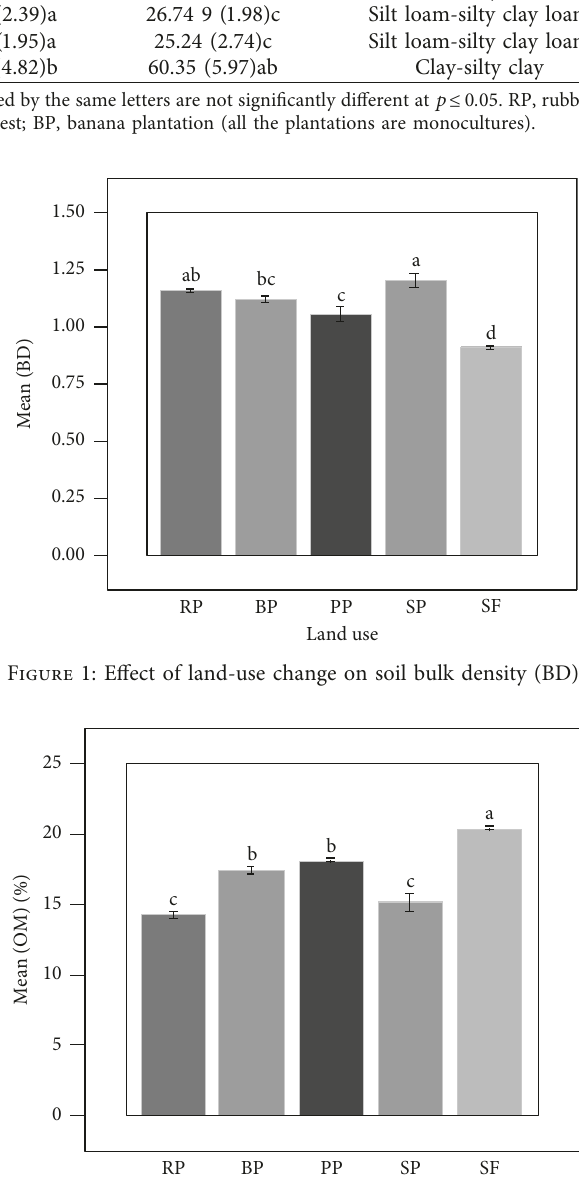
Figure 2: Effect of land use on soil organic